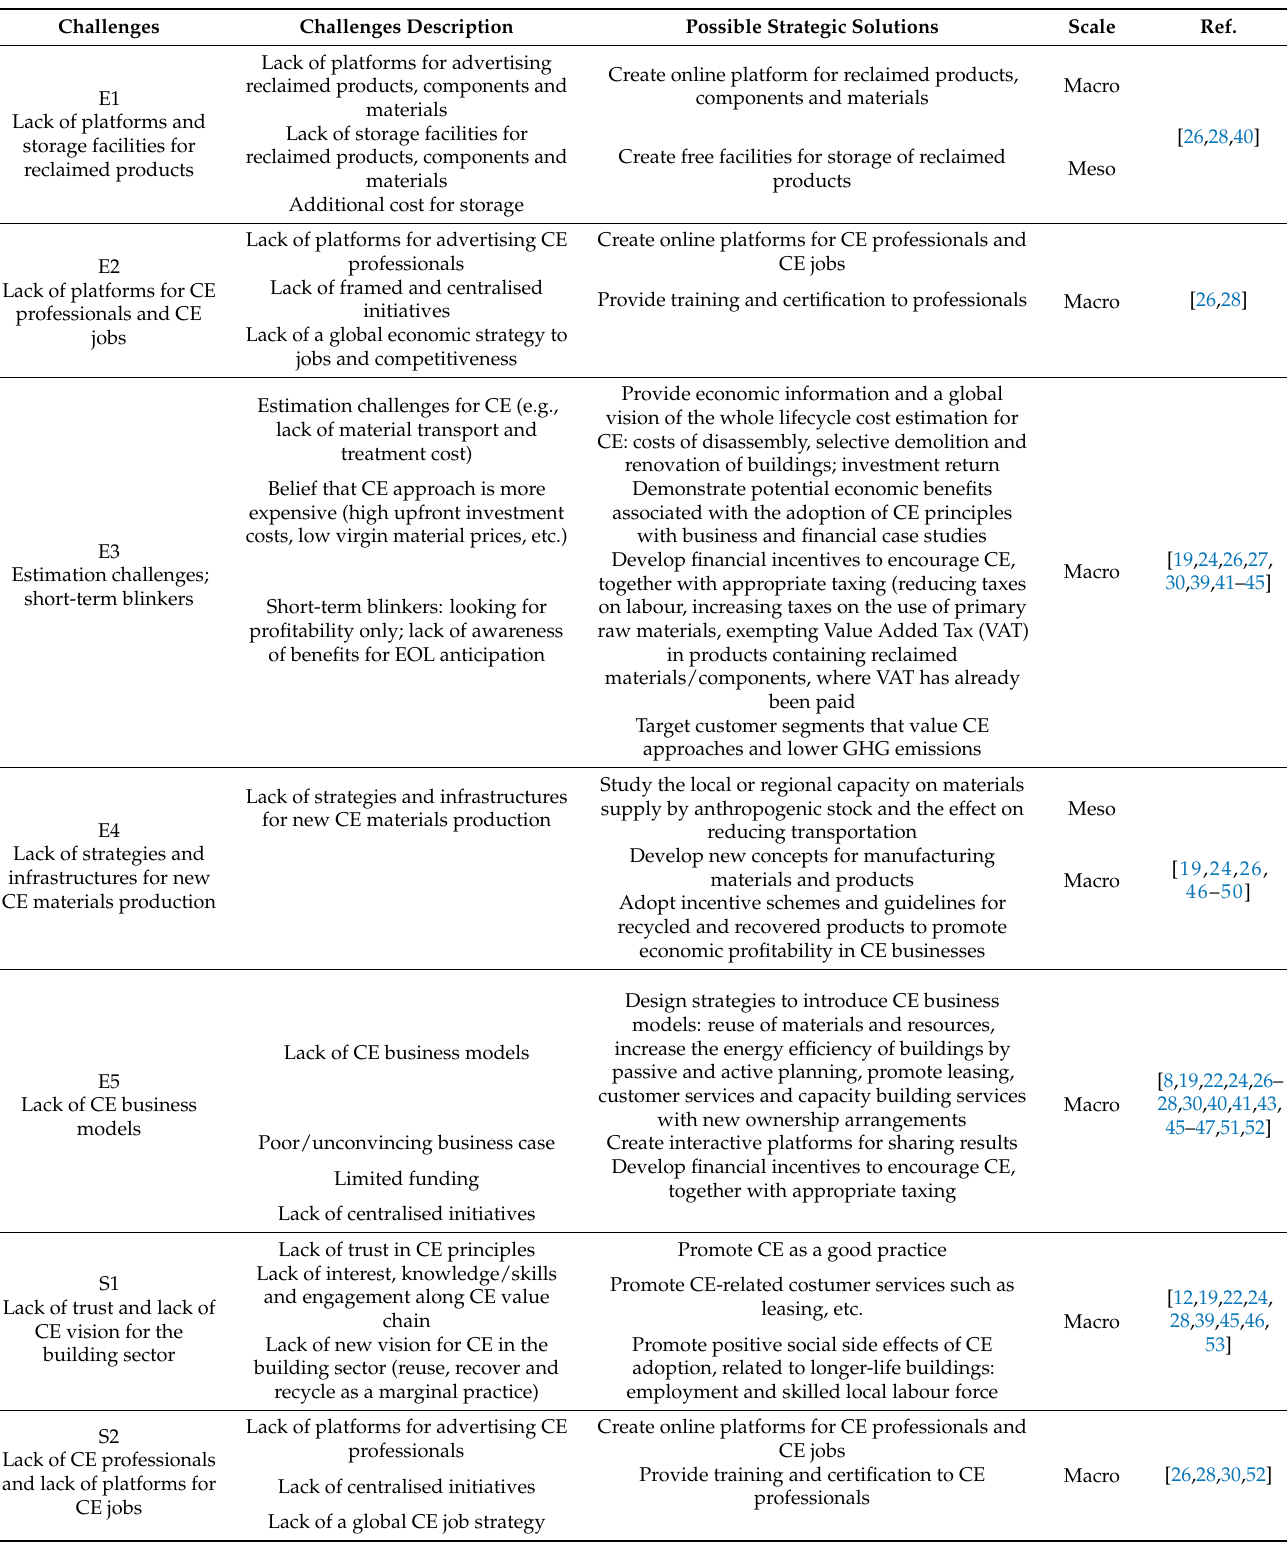
Table 2. Challenges and possible solutions for CE adoption in the existing building